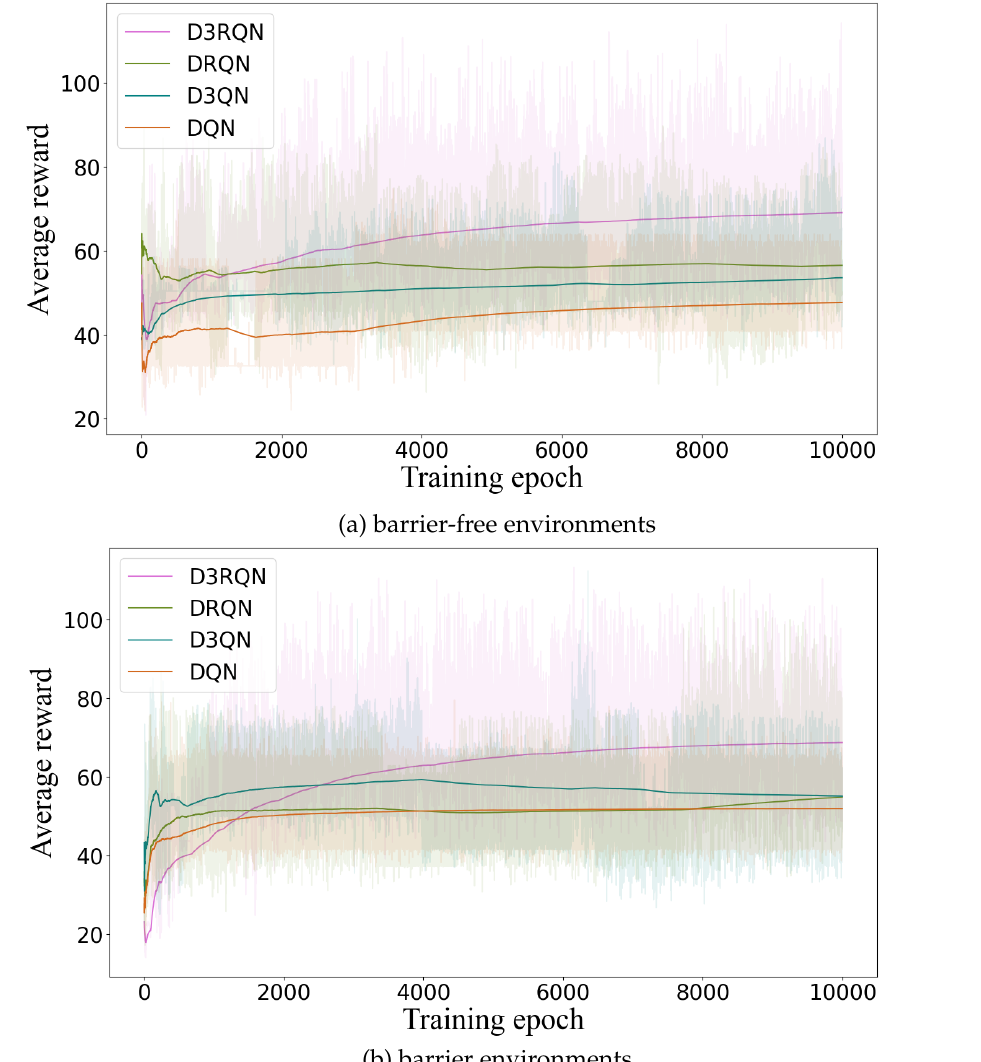
Figure 6. Comparison of the experimental results of dual observation platforms. ( a , b ) Comparison of the reward functions of DQN, D3QN, DRQN, and D3RQN running in barrier and barrier-free environments,